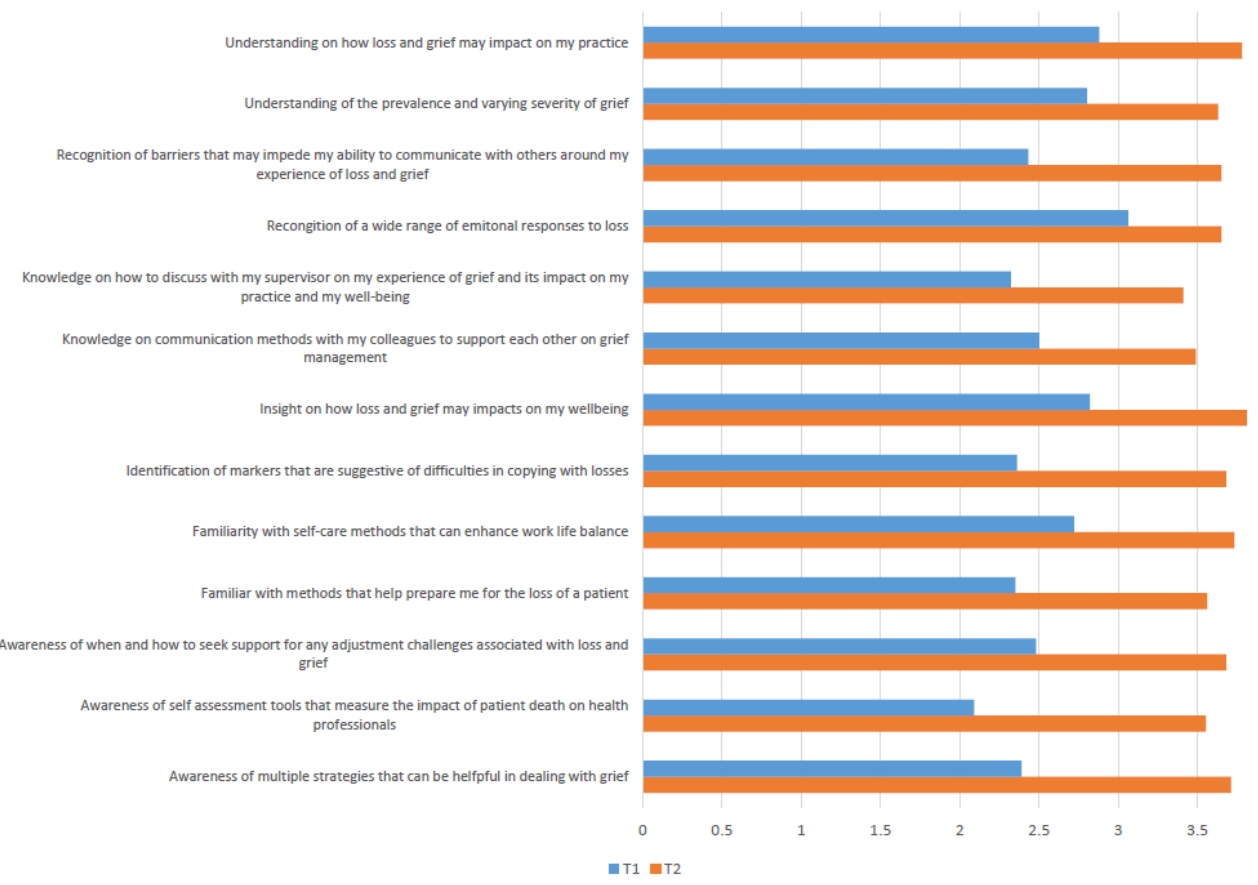
Figure 1. Perceived knowledge change. (1 = Not knowledgeable at all to 4 = Very knowledgeable).